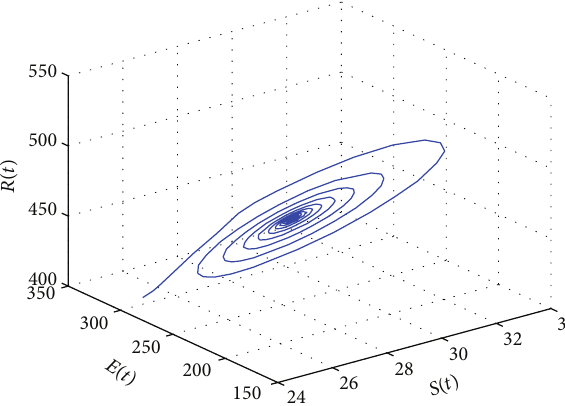
Figure 10: The phase plot of the states 𝑆 , 𝐸 , and 𝑅 for 𝜏 = 4.7500 < 5.1094 = 𝜏 0 .